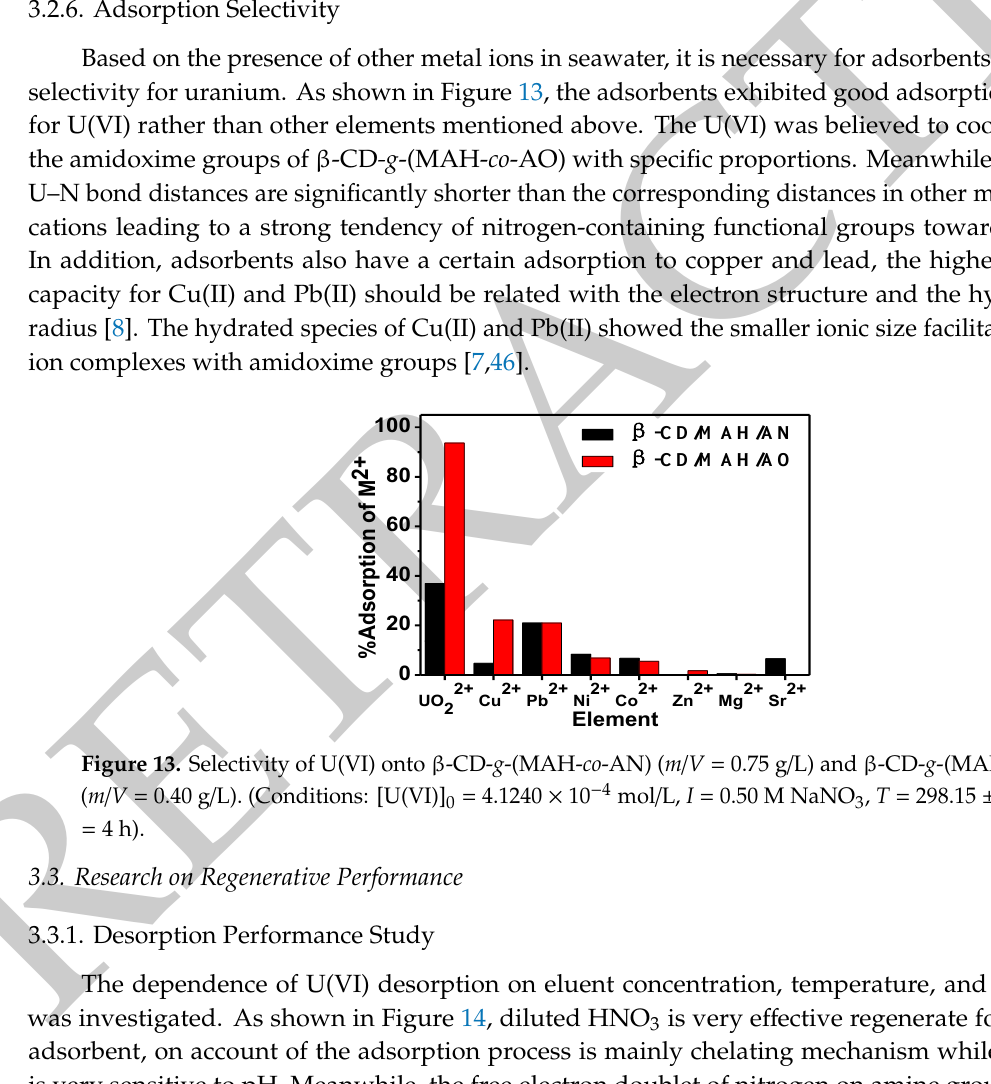
Figure 12. E ff ect of the temperature on the adsorption of U(VI) onto β -CD- g -(MAH- co -AO) (Conditions: Figure 12. Effect of the temperature on the adsorption of U(VI ) onto β -CD- g -(MAH- co -AO) pH = 4.00 ± 0.05, I = 0.50 M NaNO 3 , t = 4 h, m / V = 0.20 g / L). (Conditions: pH = 4.00 ± 0.05, I = 0.50 M NaNO 3 , t = 4 h, m / V = 0.20 g/L).